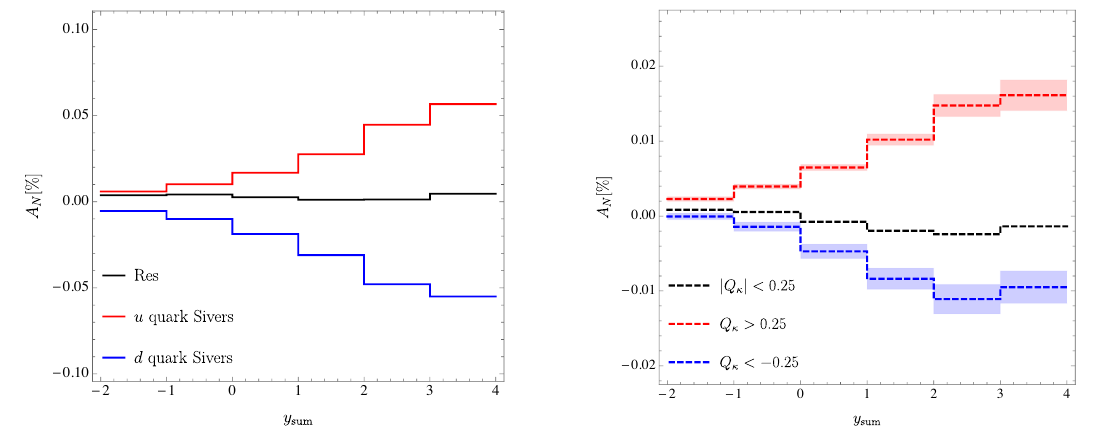
Figure 6 . Theoretical predictions of the Sivers asymmetry for dijet production at the RHIC with √ s = 200 GeV. In the left plot red and blue curves are the results from u - and d - quark Sivers function, and the black curve includes all the contributions. In the right plot we show the Sivers asymmetry distribution within three different jet charge Q κ bins. The red and blue bands indicate the theoretical uncertainties using the 200 replicas of the quark Sivers function [116]. At each point in calculation of our theoretical prediction, we retain the middle 68% of the